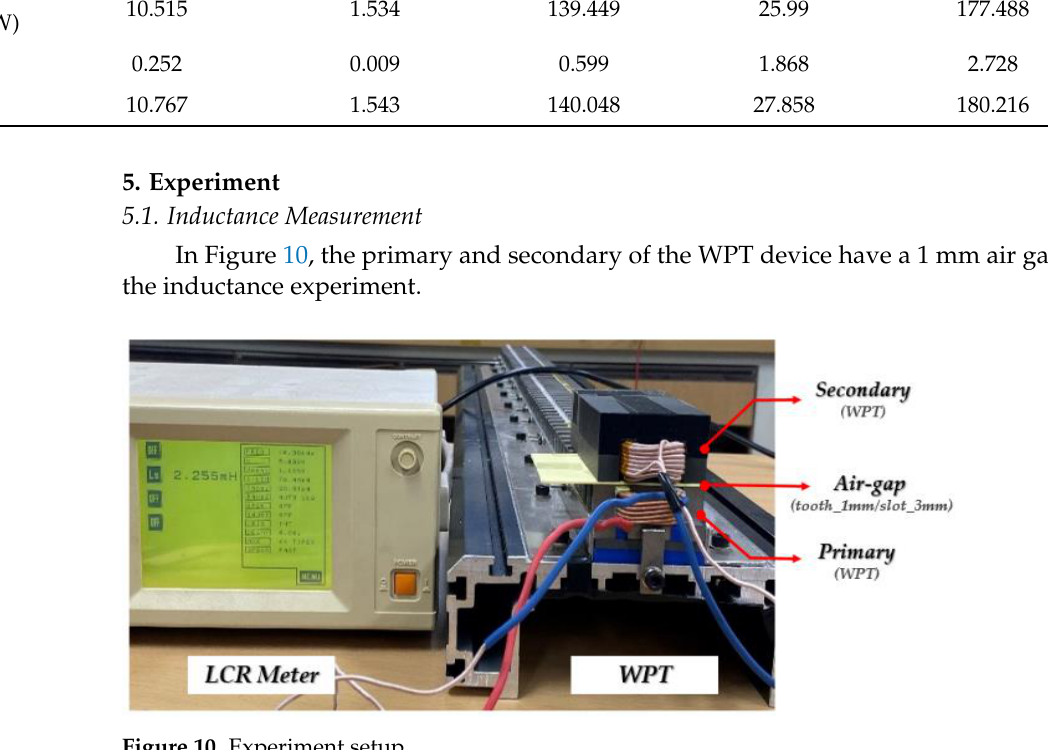
Figure 10. Experiment setup.